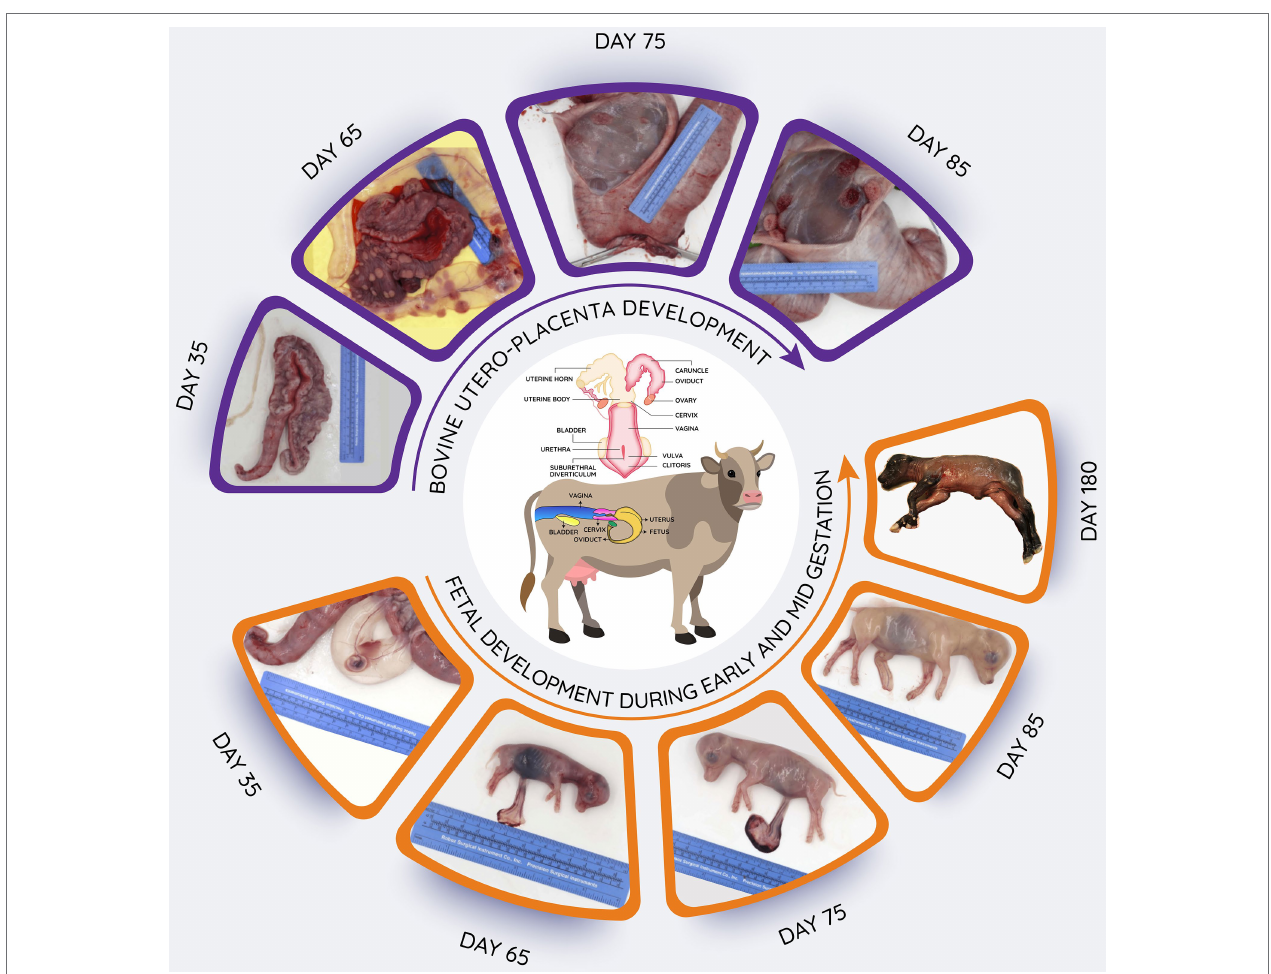
FIGURE 2 | Schematic overview of bovine reproductive tract, and images of utero-placental development from 35 to 85 days after mating as well as fetuses obtained during early (day 35) to late (day180) gestation. Length of gestation is around 280 days. In the upper images, the uterine horns have been opened to reveal the utero-placental surfaces. In the lower images, the uterus has been opened to reveal the fetus in its fetal membranes (chorioallantois and amnion; day 35) or the fetuses have been removed to illustrate their continued growth and